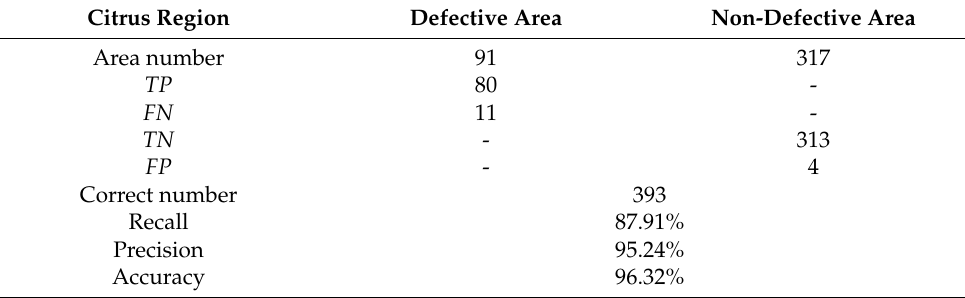
Table 1. Test statistics results of citrus regional defect detection.